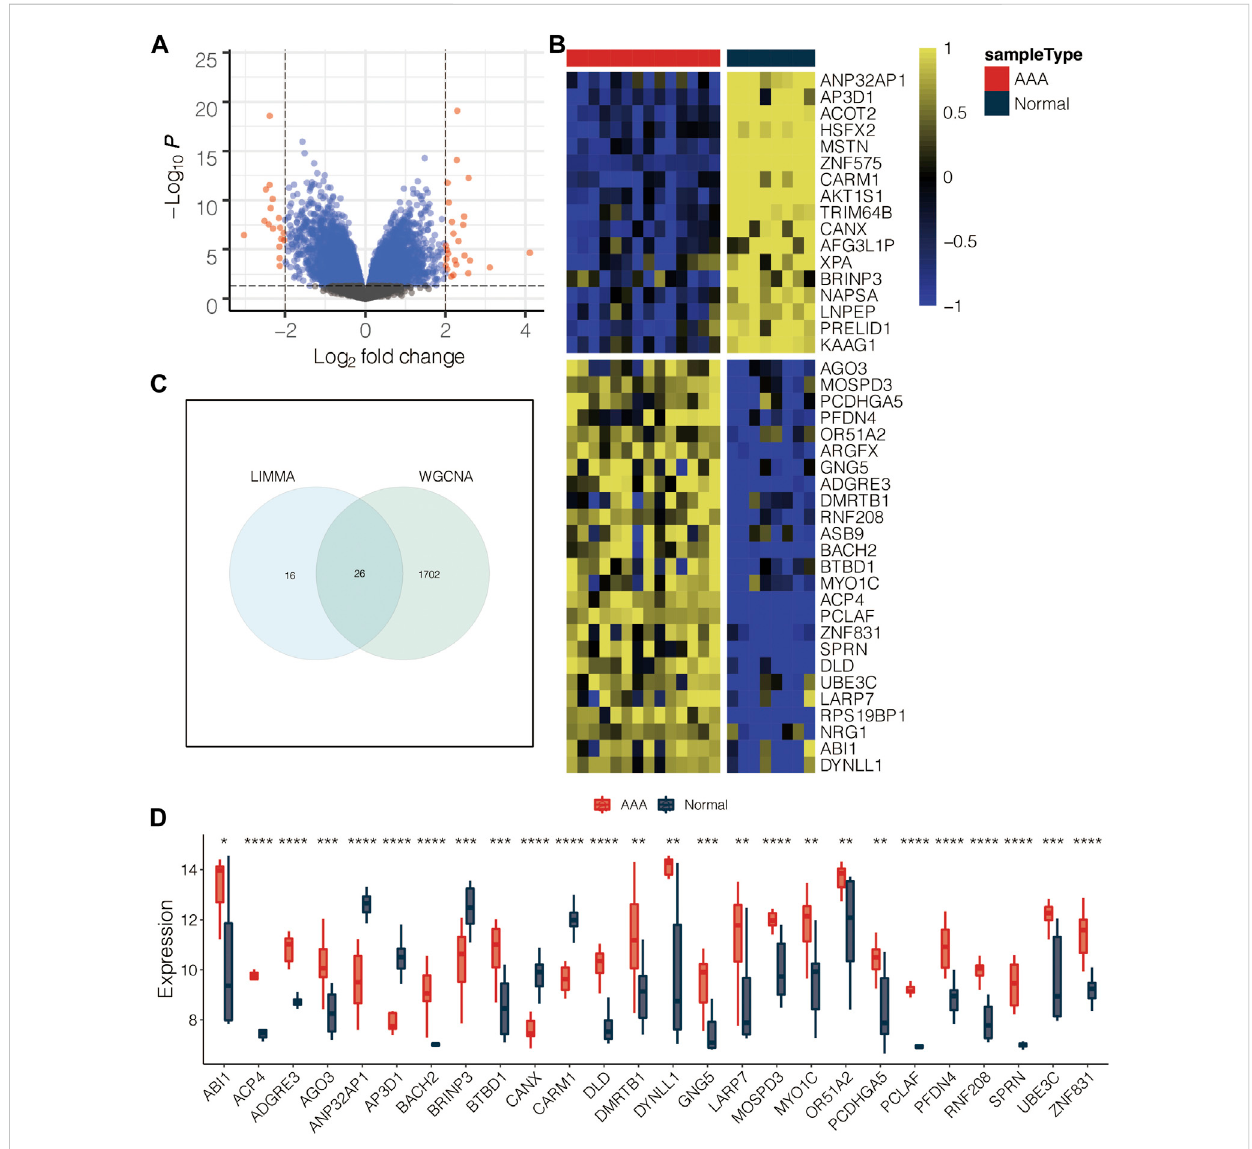
FIGURE 3 Identi fi cationoftheAAA-relatedgenes. (A) Volcanoplotforthelimma-basedDEGsbetweenAAAandnormalsamplesinGSE47472. (B) Heatmapfor the DEGs between AAA and normal samples in GSE47472. (C) Venn plot for the intersected genes between the limma-based DEGs and the WGCNA- based genes in GSE47472. (D) Box plot for the intersected genes between the limma-based DEGs and the WGCNA-based genes in